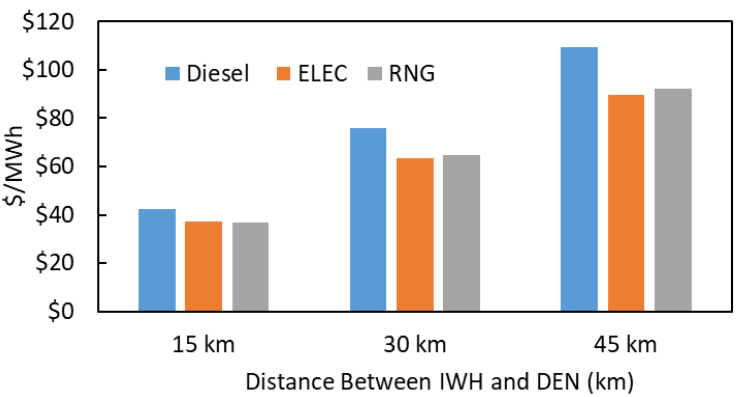
Figure 6. The M-TES levelized cost with different IWH locations and truck modes.